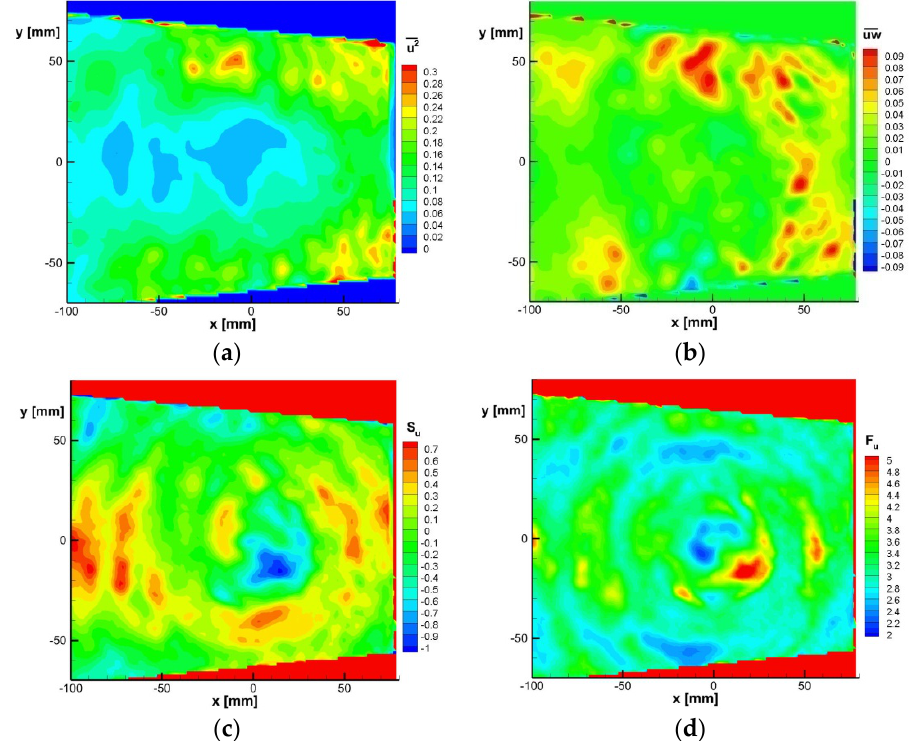
Figure 8. Reynolds stresses: ( a ) normal and ( b ) shear; statistical moments of higher order: ( c ) skewness factor and ( d ) flatness factor.